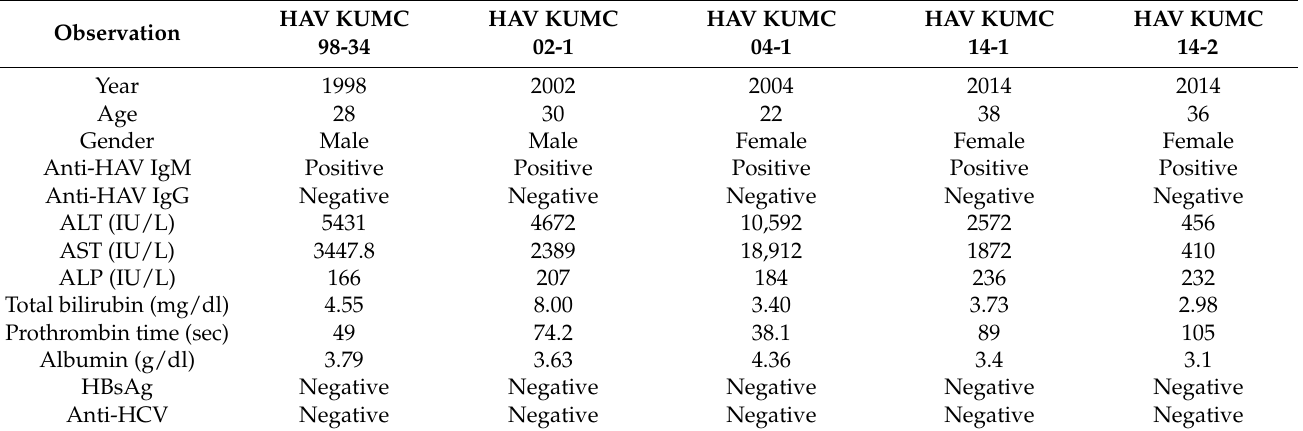
Table 1. Characteristics and laboratory test results of patients with acute hepatitis A infection in the Republic of